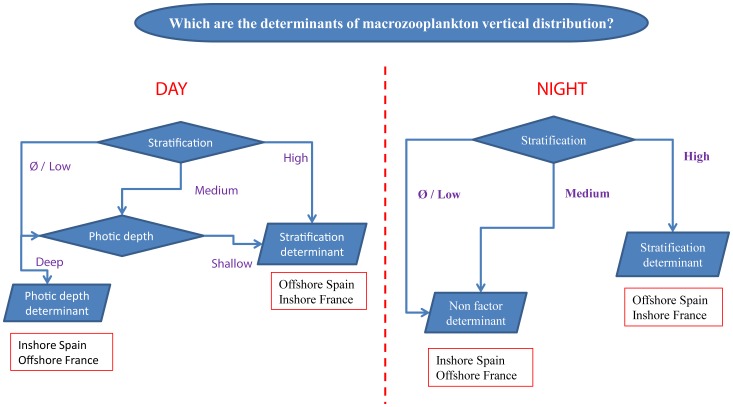
Flow chart showing the nested and interacting nature of the environmental effects on macrozooplankton.